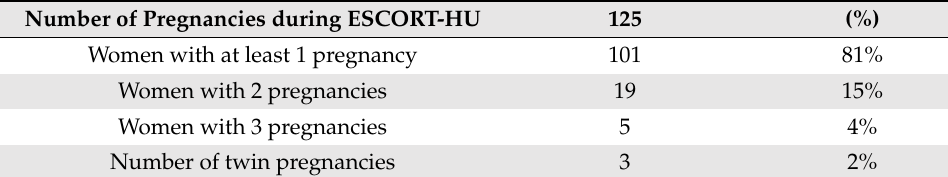
Table 1. Number of pregnancies before and during the study.